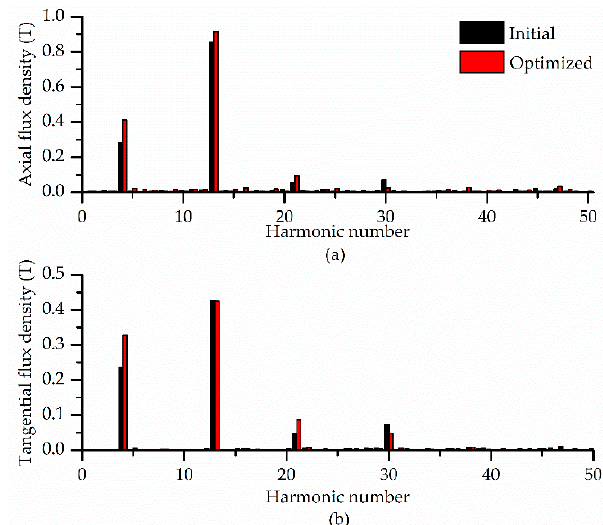
Figure 11. Fast Fourier transformation (FFT) analysis of the axial and tangential flux densities at the radius of R m1 in the air gap adjacent to the low-speed rotor (LG) of the HAMG. ( a ) Axial flux density; ( b ) Tangential flux density. Table 7. Amplitudes, the phase differences and torque due to the air-gap flux density at the radius of R m1 .